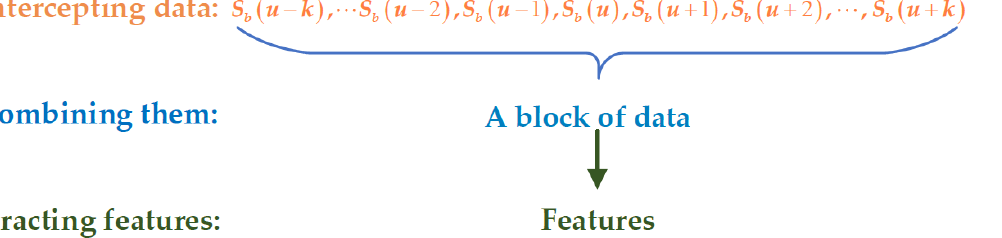
Figure 2. Flowchart of the FOD classification. PSO: Particle Swarm Optimization.